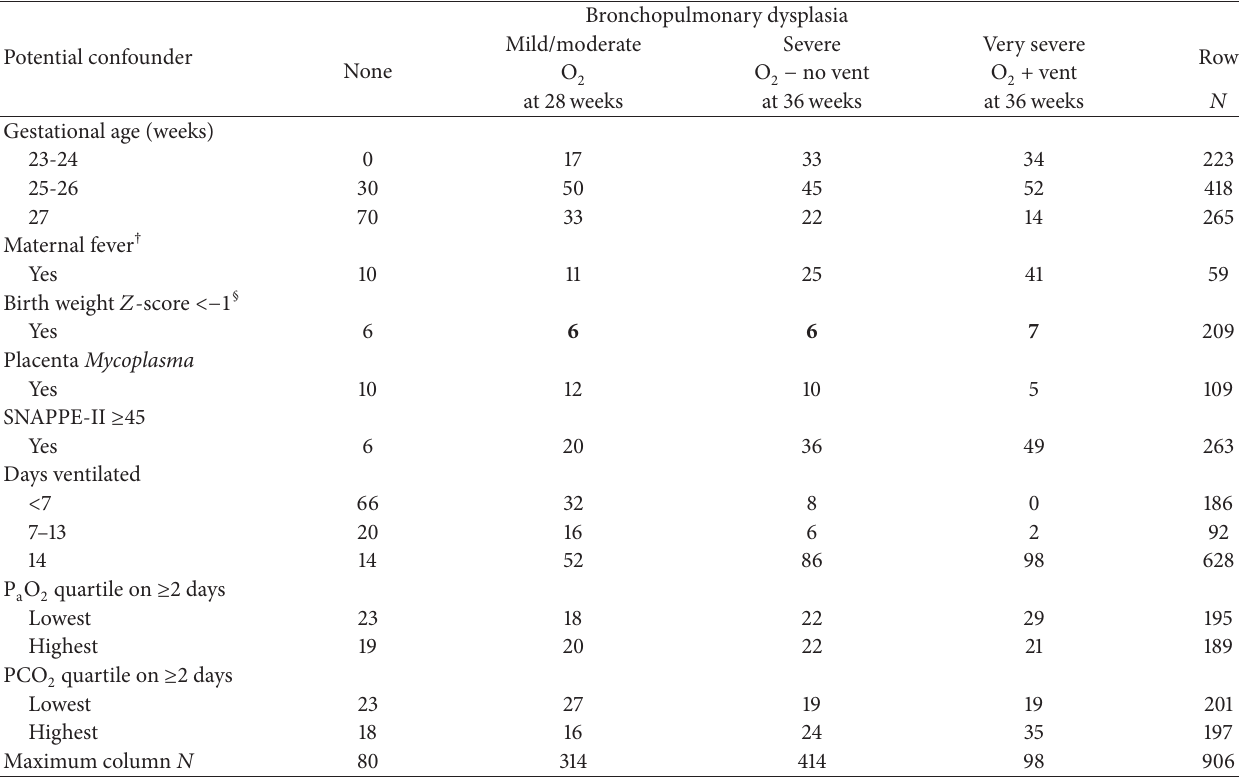
§ Birth weight 𝑍 -scores based on Yudkin et al. [14] standard. † Maternal temperature > 100.4 ∘ F during